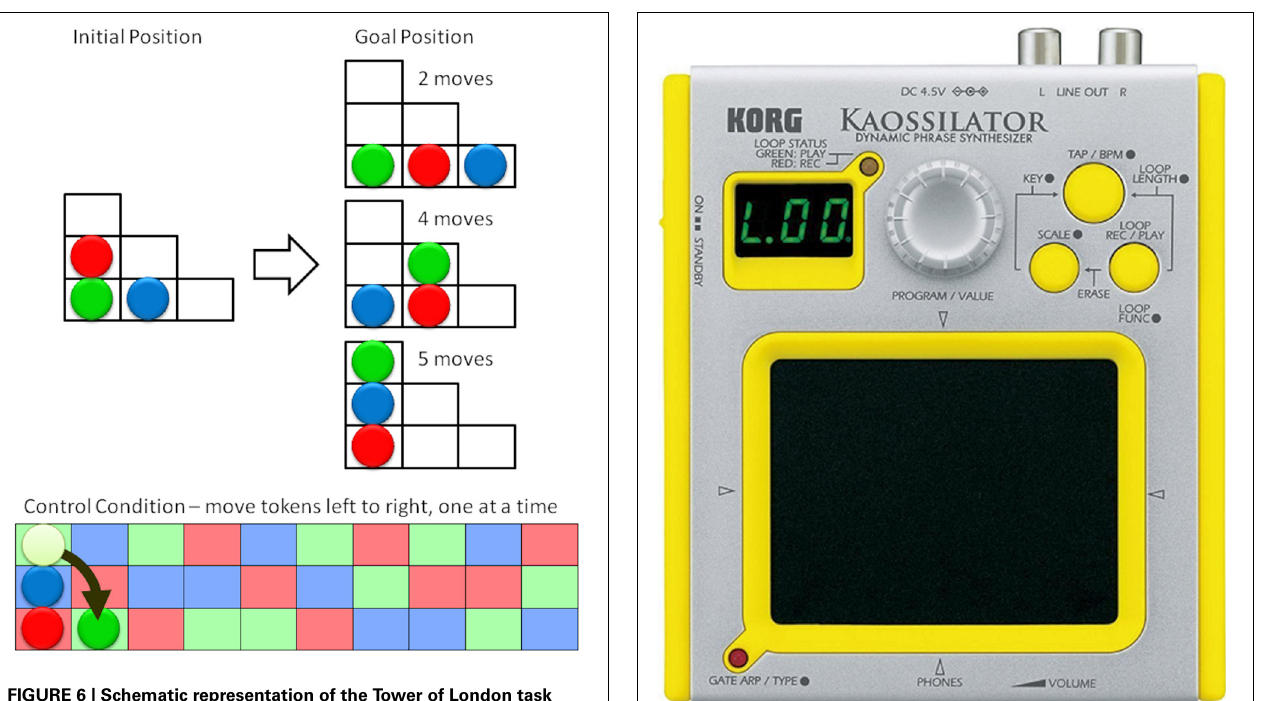
FIGURE 6 | Schematic representation of the Tower of London task (top) and the control condition (bottom). The aim is to move the three colored tokens from the initial position (left) to the goal position (right) in the minimum number of moves. Subjects were asked to first plan and then to execute their moves. In the control condition subjects were asked to move the tokens from left to right, following the color pattern. The next moves would be to move the blue token up and right, then the red token up and right, etc.